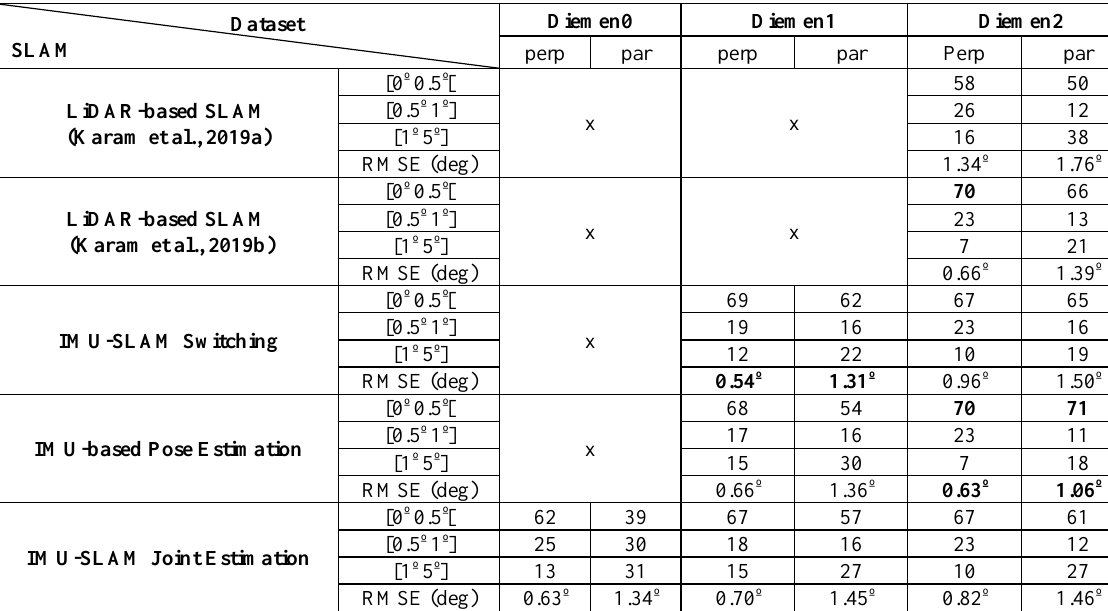
Table 3. Comparison between the performance of the proposed method on all datasets regarding the number of assigned points (Nr), the corresponding RMSEs of the residuals, and the percentage of residuals below 3 cm (Perc). The results of two previously developed methods are also listed at the beginning of the table for comparison. The letter “x” refers to the failure of the method to process the corresponding dataset.